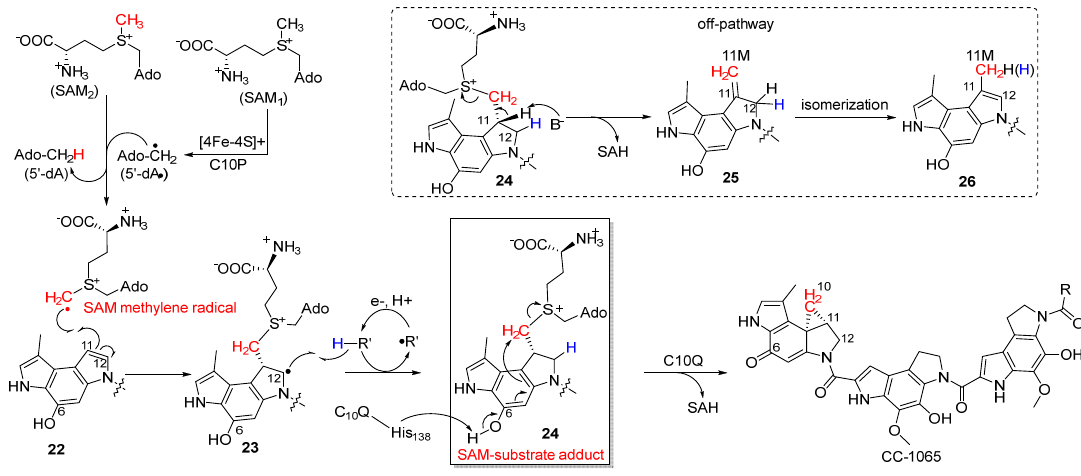
Figure 5. Proposed enzymatic mechanism of the cyclopropane moiety formation catalyzed by C10P and C10Q.